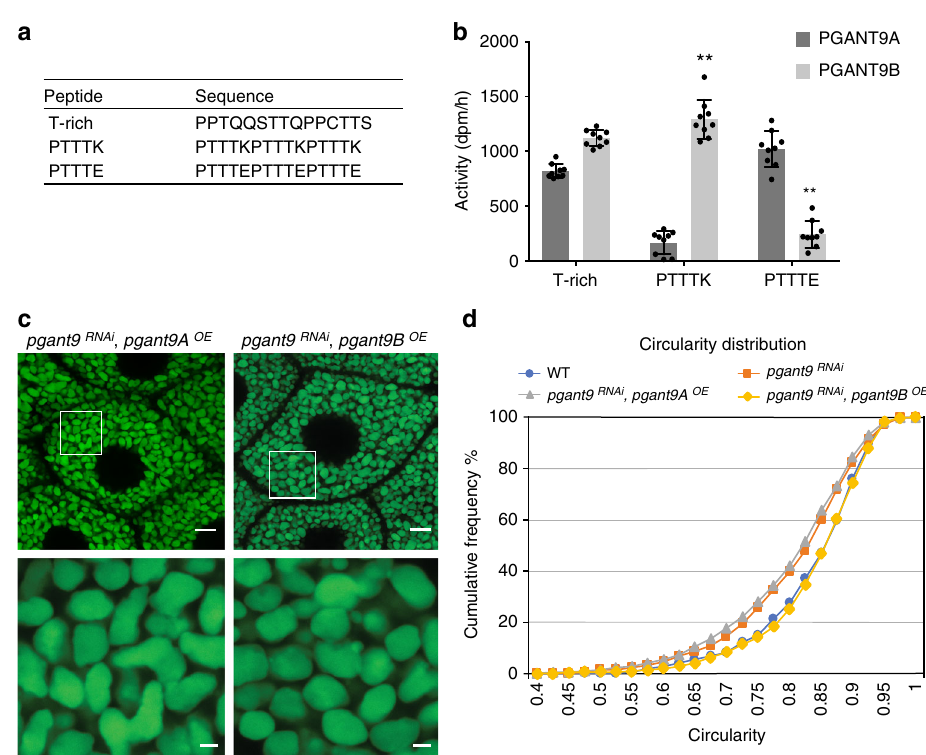
Fig. 7 PGANT9B glycosylates Sgs3 and rescues secretory granule morphology. a Peptides used for in vitro reactions. T-rich is a peptide within the T-rich domain of Sgs3. PTTTK is a peptide within the positively-charged PTTTK repetitive region of Sgs3. PTTTE is a version of PTTTK where all positively- charged amino acids (K; lysine) have been replaced with negatively-charged amino acids (E; glutamic acid). b In vitro enzymatic assays measuring the glycosyltransferase activity of puri fi ed PGANT9A and PGANT9B against peptides derived from Sgs3. Values represent the mean ± s.d. from duplicate reactions. Assays were repeated three times. Student ’ s t -test was used to calculate p values (** p < 0.01). c Confocal images of third instar larval SGs from pgant9 RNAi larvae that overexpress either pgant9A ( pgant9 RNAi , pgant9A OE ) or pgant9B ( pgant9 RNAi , pgant9B OE ). All genotypes also express Sgs3-GFP (green). The white boxed area in the upper panels is enlarged below each image. Representative images from three independent experiments are shown. Scale bars, 10 μ m for upper panels and 2 μ m for lower panels. d Graphs of the cumulative frequency of granule circularity for each genotype are shown. Granule circularity quanti fi cation was performed on three individual SGs from three independent biological replicates. Cumulative frequency graph of pgant9 RNAi , pgant9A OE ( n = 931 granules) and pgant9 RNAi , pgant9B OE ( n = 946 granules) is overlapped with the data shown in Fig. 1b for WT and CG30463 RNAi ( pgant9 RNAi ). QPCR data to verify mRNA expression of pgant9A and pgant9B are shown in Supplementary Fig. 4a and western blots to